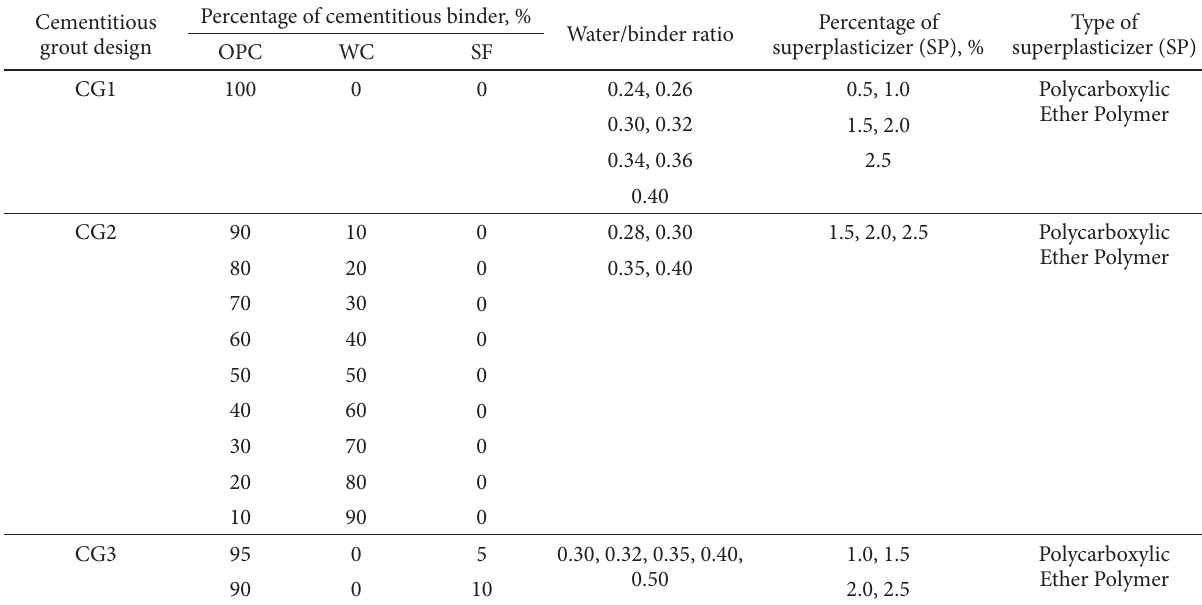
Table 1. Mix details of cementitious grout mixtures Cementitious grout